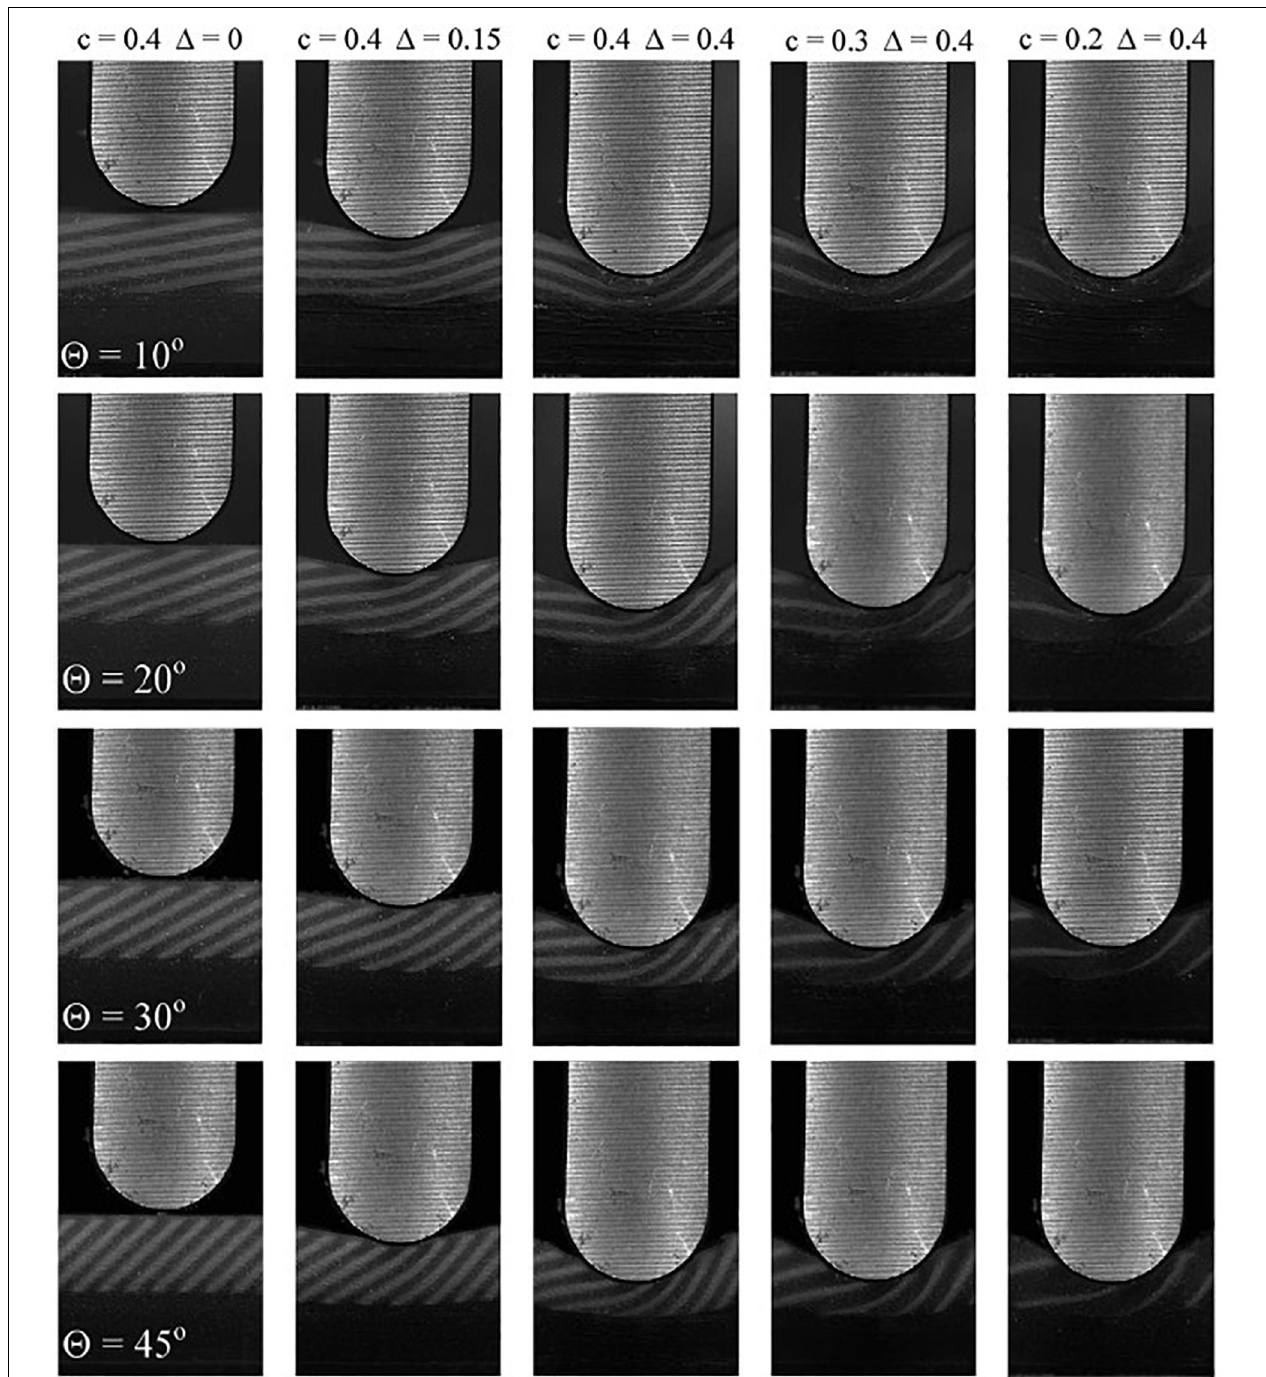
FIGURE 10 | Deformation illustration on the laminates of scales at increasing inclination angles (top to bottom) with decreased volume fraction and increased indentation depth (left to right) (c: volume fraction) (Rudykh et al., 2015).